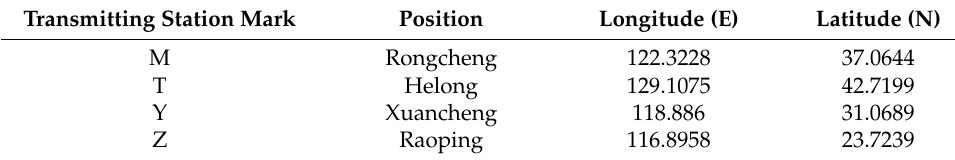
Table 2. Transmitting station location and coordinates.